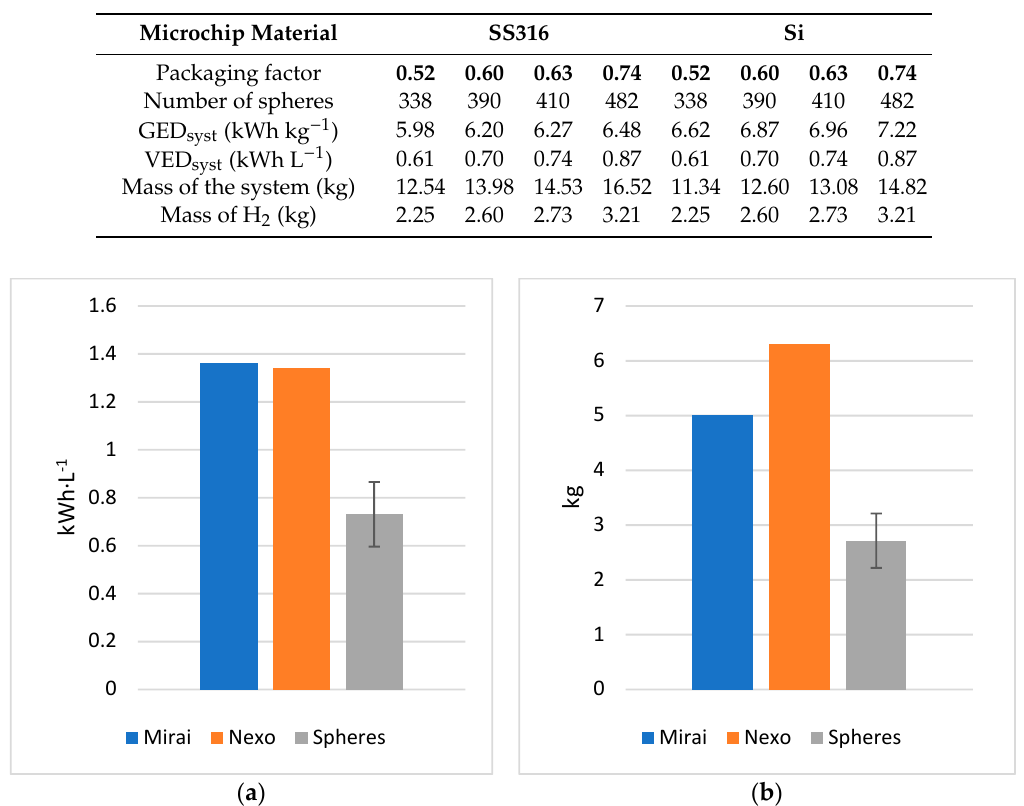
Table 10. Characteristics of the storage system (storage tank + spheres), using di ff erent packaging factors, CS 1.41.